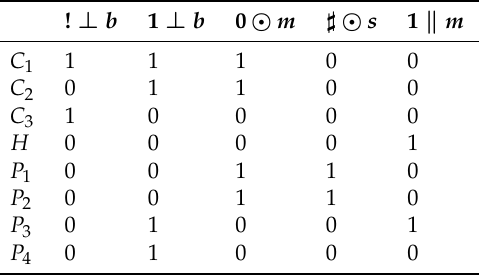
Table 6. A formal context of the